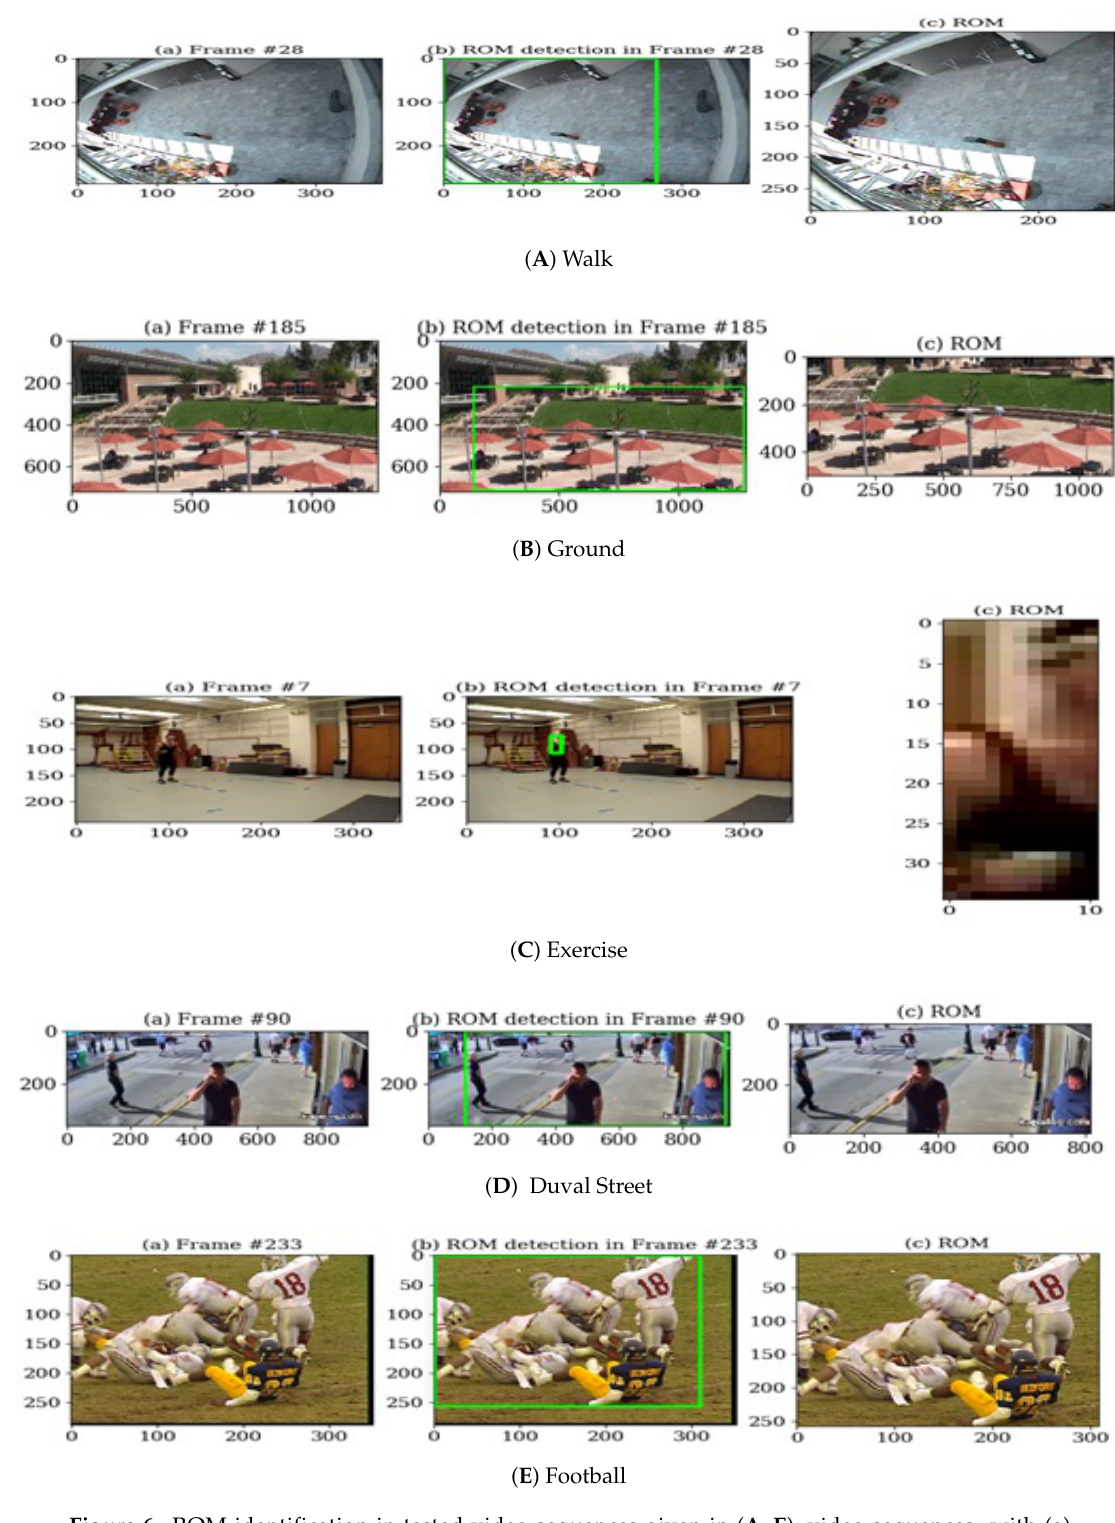
Figure 6. ROM identification in tested video sequences given in ( A – E ): video sequences: with (a) Original frame from the video sequence, (b) Identification of a ROM, (c) Cropped image of a